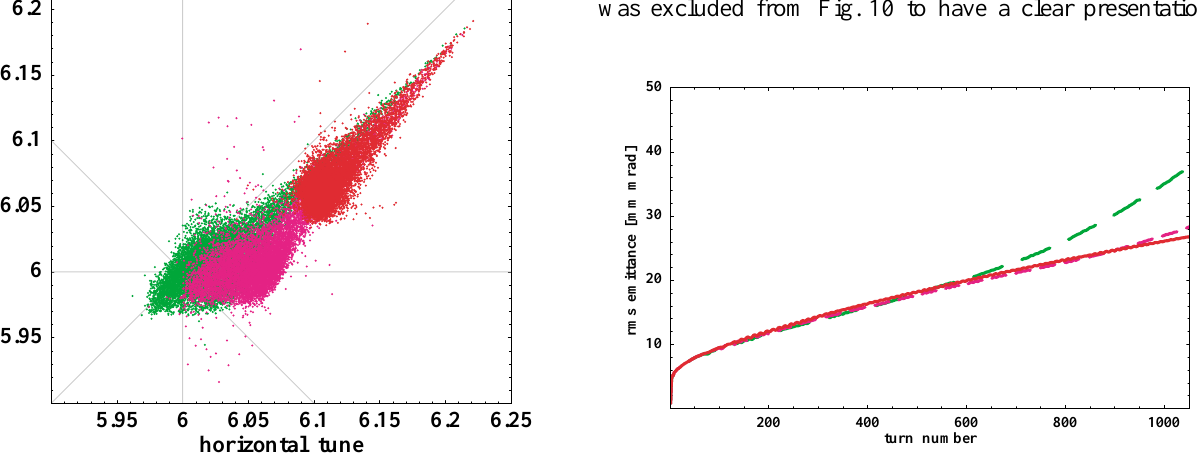
Simulations are performed with 1052-turn injection for a beam with momentum spread of dp (cid:1) p (cid:1) 0.7% . The tune footprints of a final full intensity beam are plotted at the end of the accumulation process. Here, plotted incoherent tunes are obtained using the ORBIT approach [15], which is based on tracking the phase advance of each particle over a single turn. Figure 10 shows footprints for three beam intensities N (cid:1) 2 3 10 14 (red), N (cid:1) 3 3 10 14 (pink), and N (cid:1) 4 3 10 14 (green). Here N is the number of protons in the SNS beam. Note that a dp (cid:1) p spread was present in the simulation, but its effect on the tune spread was excluded from Fig. 10 to have a clear presentation